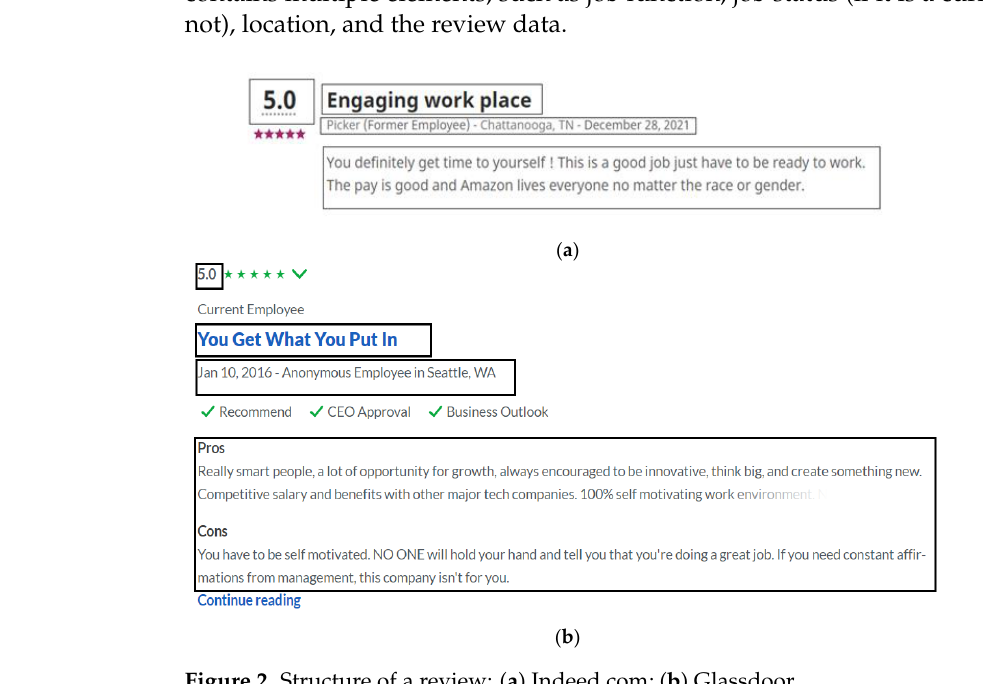
Figure 2. Structure of a review: ( a ) Indeed.com; ( b ) Glassdoor.